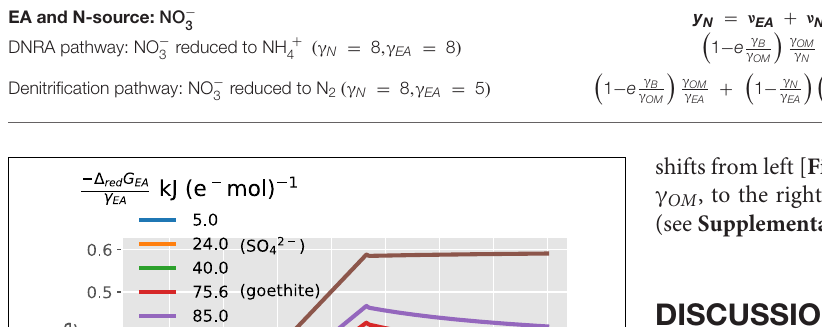
(cid:16) 1 (cid:17) = 0 , γ N = 0 CN OM